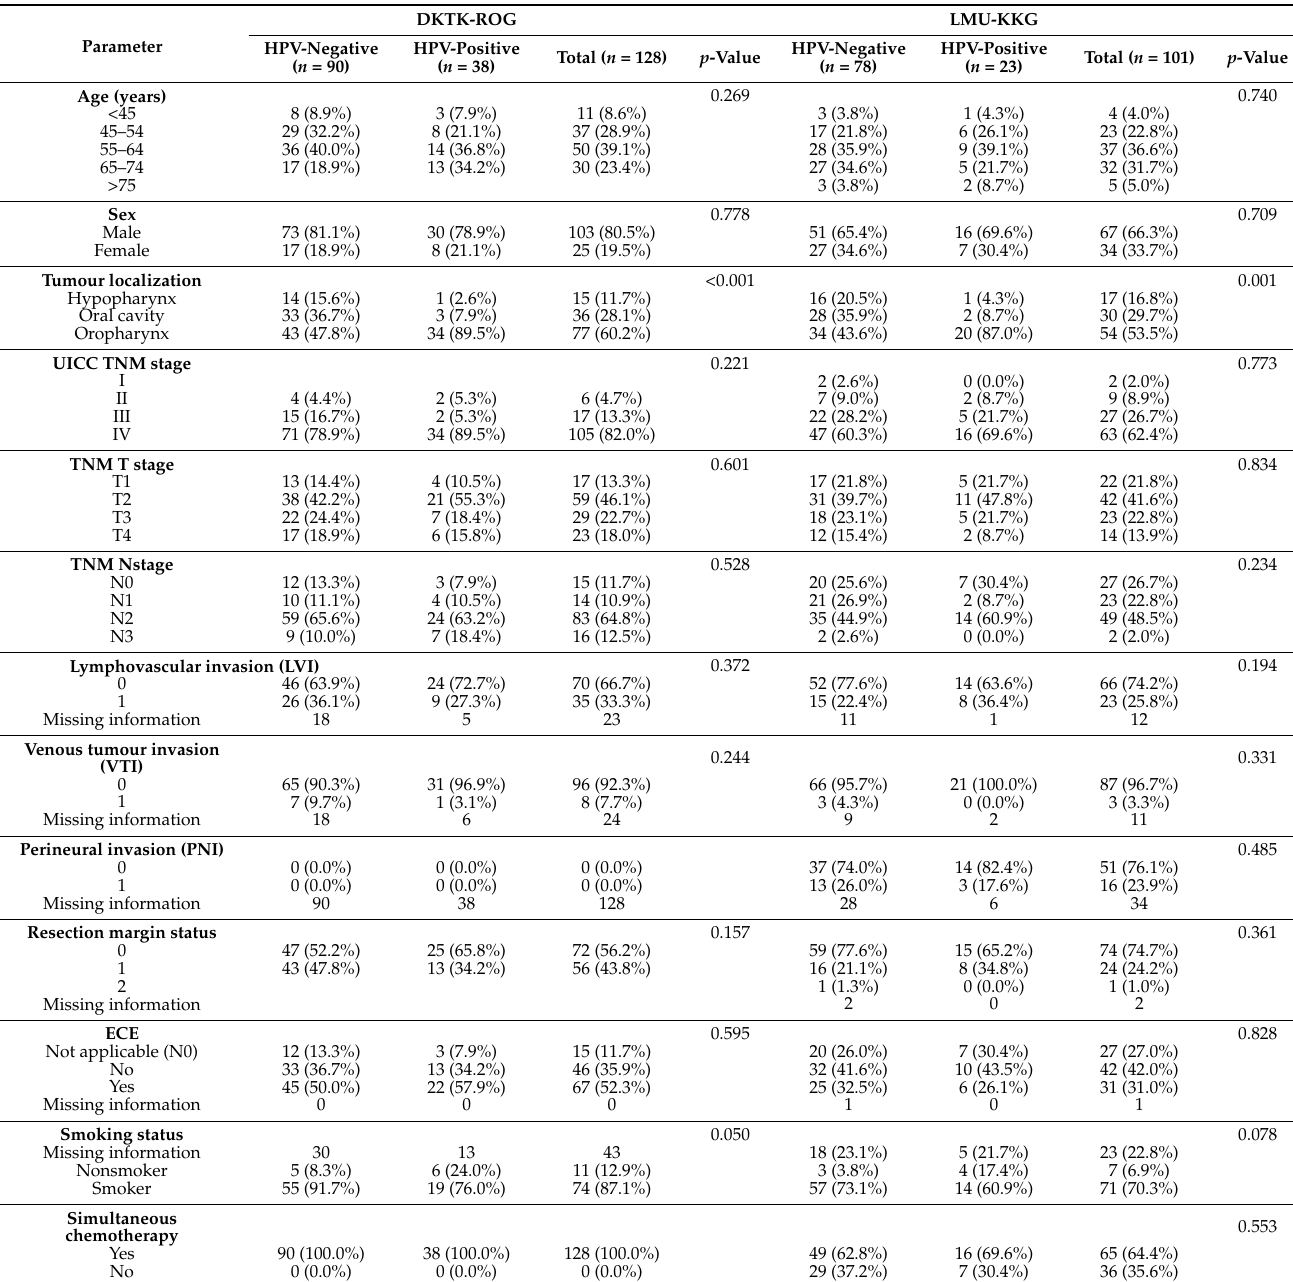
Table 1. Clinicopathological HNSCC patient